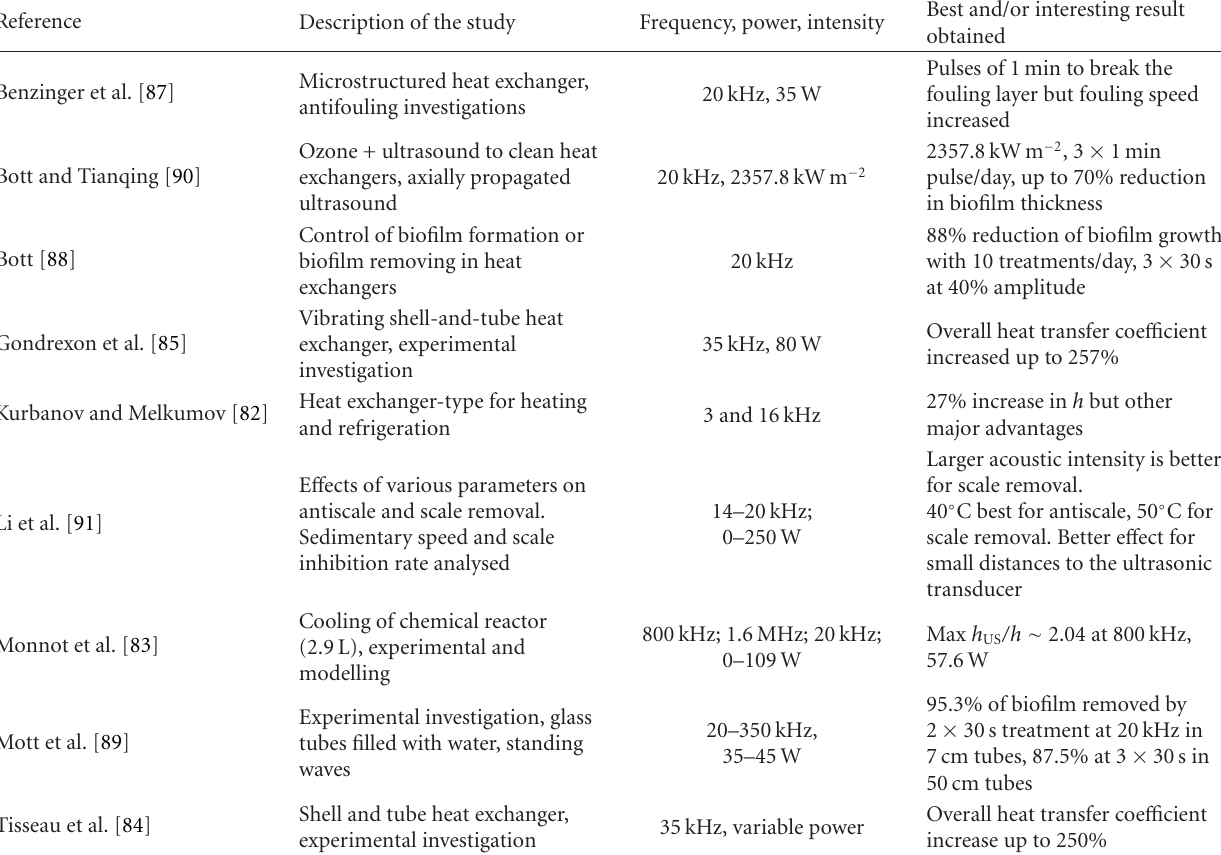
Table 6: Review of vibrating structures for heat exchangers and their